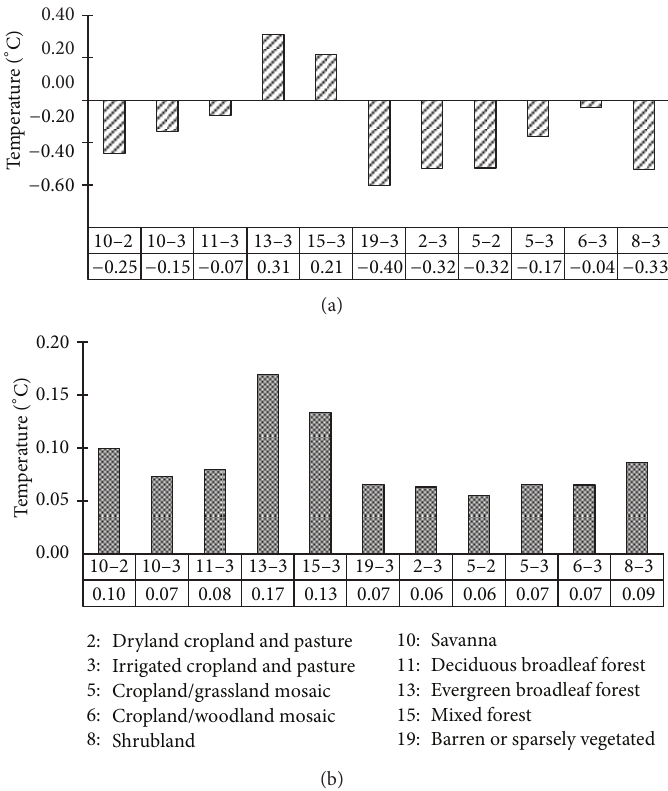
Figure 4: Change of the monthly average temperature of different types of LUCC in the future reclamation of cultivated land in the summer (a) and the winter (b). Note: 𝑖 - 𝑗 ( 𝑖 , 𝑗 are codes of land use/cover types) refers to the conversion from the land use/cover of 𝑖 to that of 𝑗 .